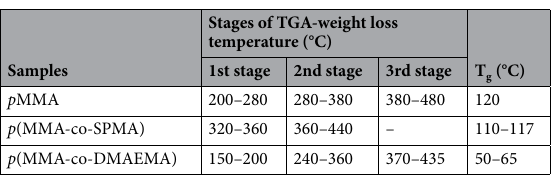
Table 1. TGA and DSC of copolymers.